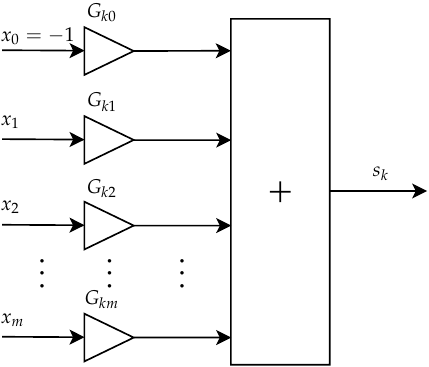
Figure 19. Architecture of the Transfer Function Submodule.